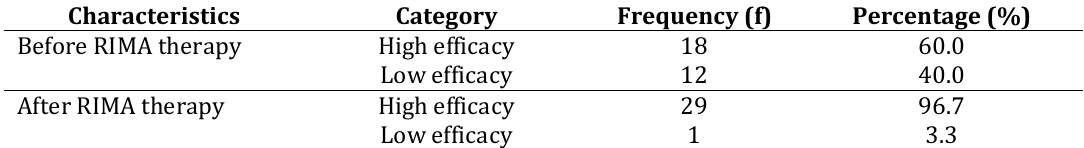
Experimental Group Self-Efficacy Characteristics